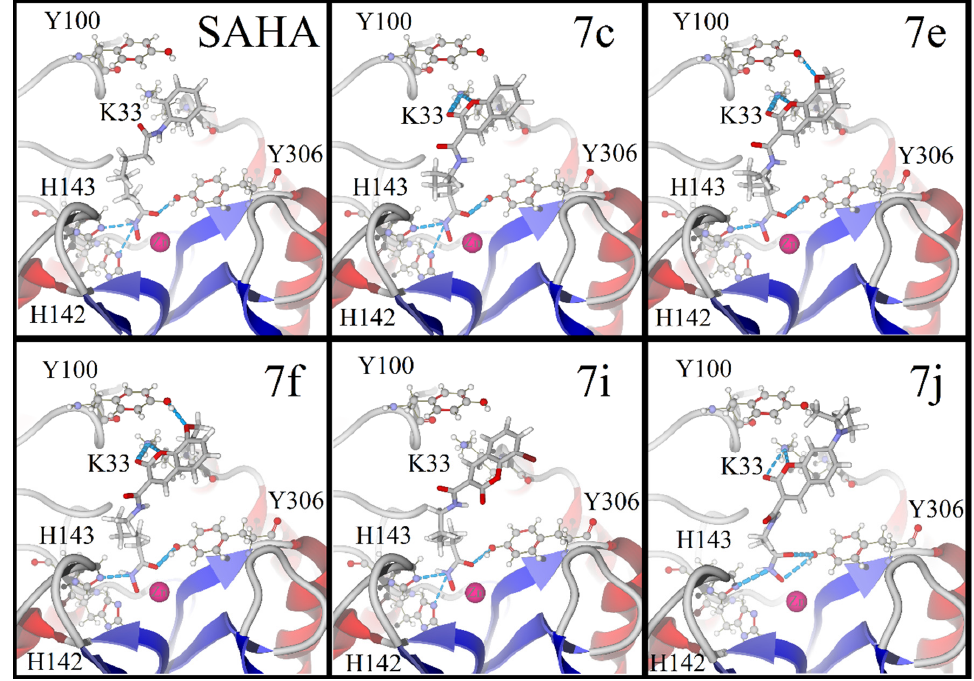
Figure 8. Hydrogen-bond interactions (blue lines) for SAHA, 7c , 7e , 7f , 7i , 7f and 7j in the pocket of HDAC8. Zinc atom displayed as a pink sphere. Molecules 2020 , 25 , x FOR PEER REVIEW